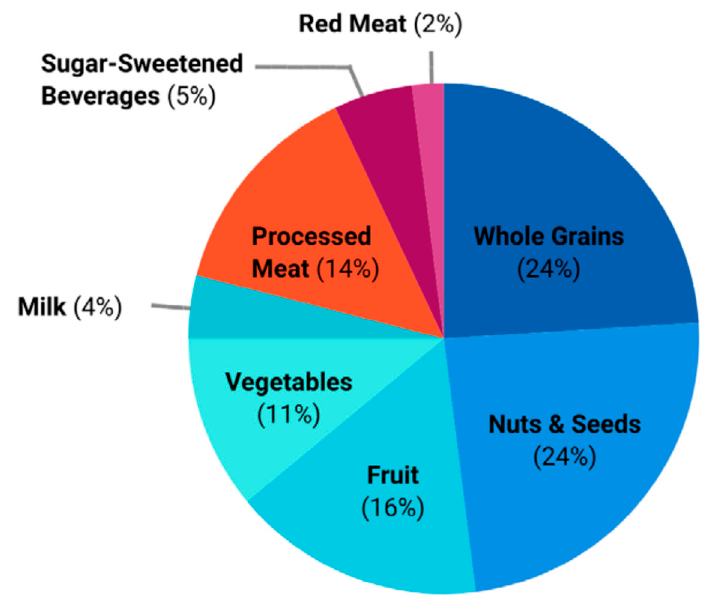
Figure 1. Proportion of CAD$15.8 billion economic burden attributable to not meeting established food recommendations.